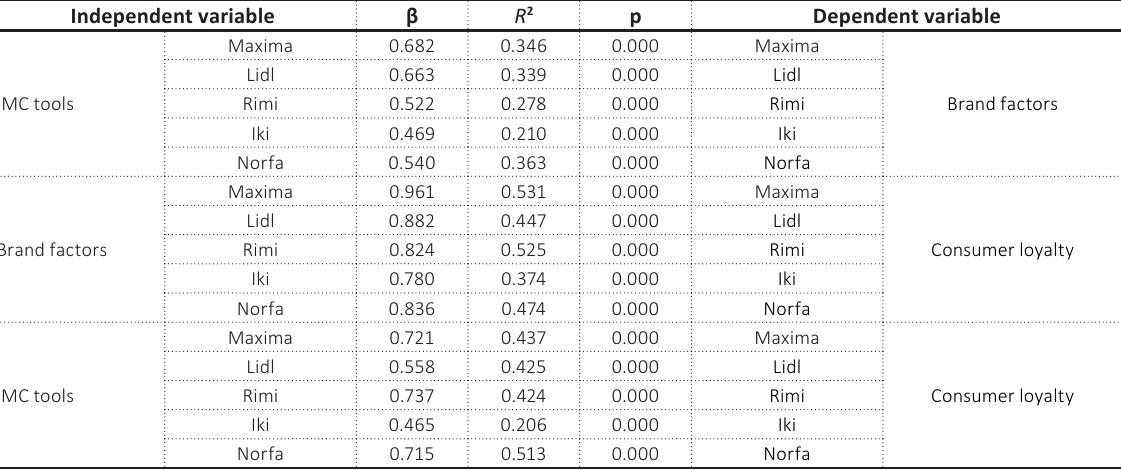
Table 4. Main impact on